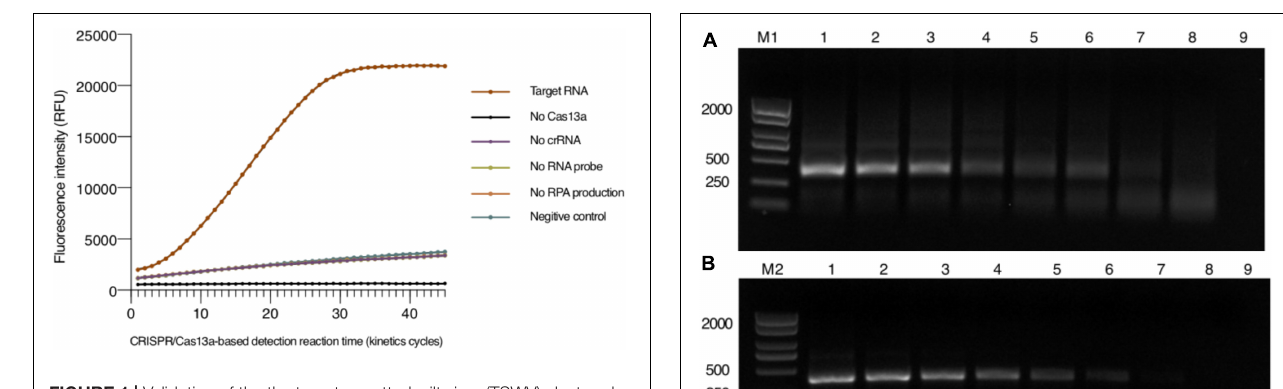
FIGURE 1 | Validation of the the tomato spotted wilt virus (TSWV) clustered regularly interspaced short palindromic repeats (CRISPR)/clustered regularly interspaced short palindromic repeat-associated 13a (Cas13a)-based detection system. The positive sample in a 100- µ l detection buffer contained a plasmid of the TSWV N gene as the template for RPA reaction, T7 RNA polymerase, NTP, recombinant RNase inhibitor, purified LwCas13a, crRNA, and RNA reporter. The detection systems were monitored in the absence of LwCas13a, crRNA, RNA probe, or RPA amplification products. The negative control utilized RNase-free water as a template of the RPA reaction. RPA, recombinant polymerase amplification. tag, and the LwCas13a protein was 138 KDa as shown in